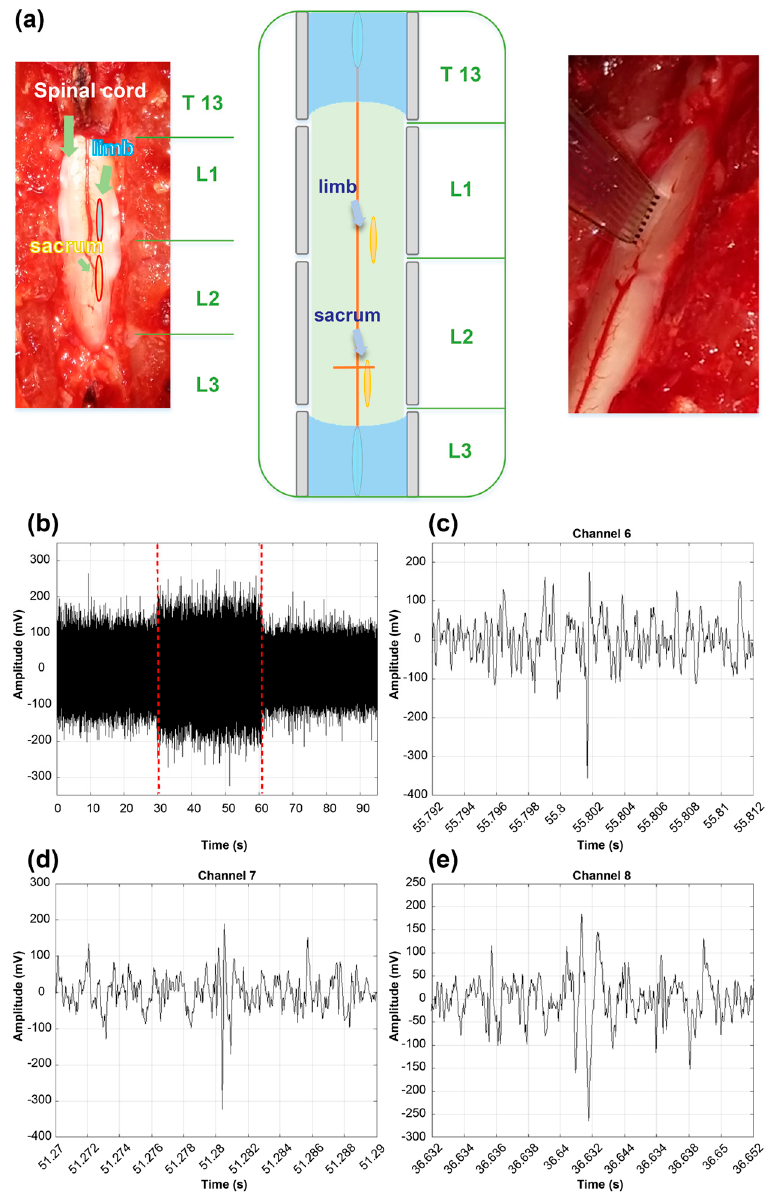
Figure 10. In vivo experiment. ( a ) In vivo placement of a PDMS-based MEA on a rat spinal cord. ( b ) Raw data from Channel 7. The period of the stimulus is indicated by the red dotted-lines. ( c ) An SSEPR from Channel 6. ( d ) An SSEPR from Channel 7. ( e ) An SSEPR from Channel 8.